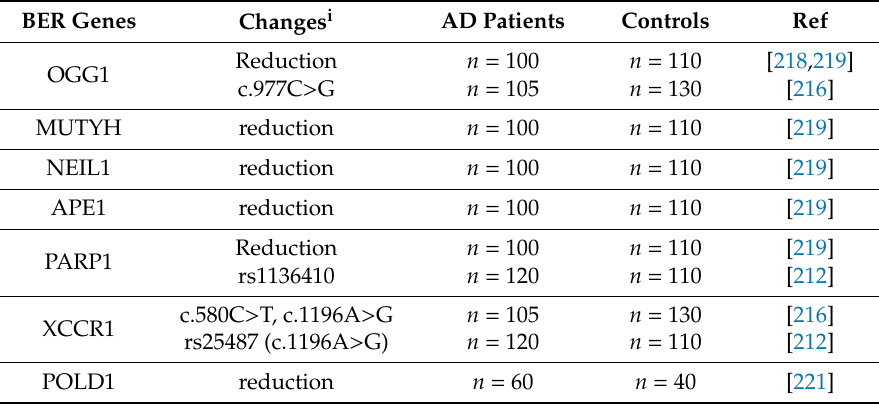
Table 2. Alteration of BER genes in PBMCs of AD